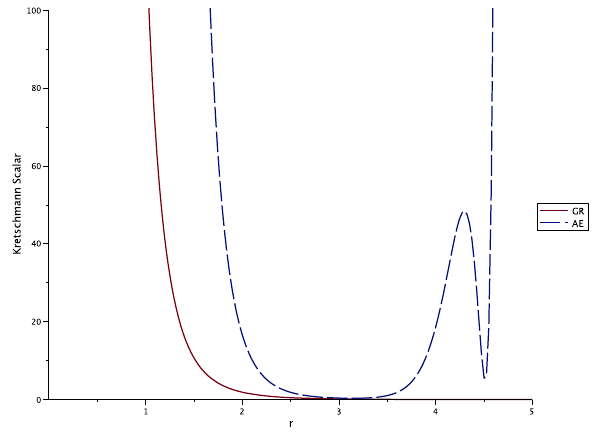
Fig. 9 Plot of the Kretschmann scalar, for EA parameters c 14 = − 16, | κ | = 1 and an arbitrary Schwarzschild mass M = 32 1 3 / 2. The con- tinuous red line represents the GR Schwarzschild metric. The dashed blue line represents the EA solution. Calculating the limit r → +∞ we obtain K → +∞ , as we can see in this figure. Calculating the limit from left r → r sing 1 = 0 we obtain K → +∞ , as we can see in